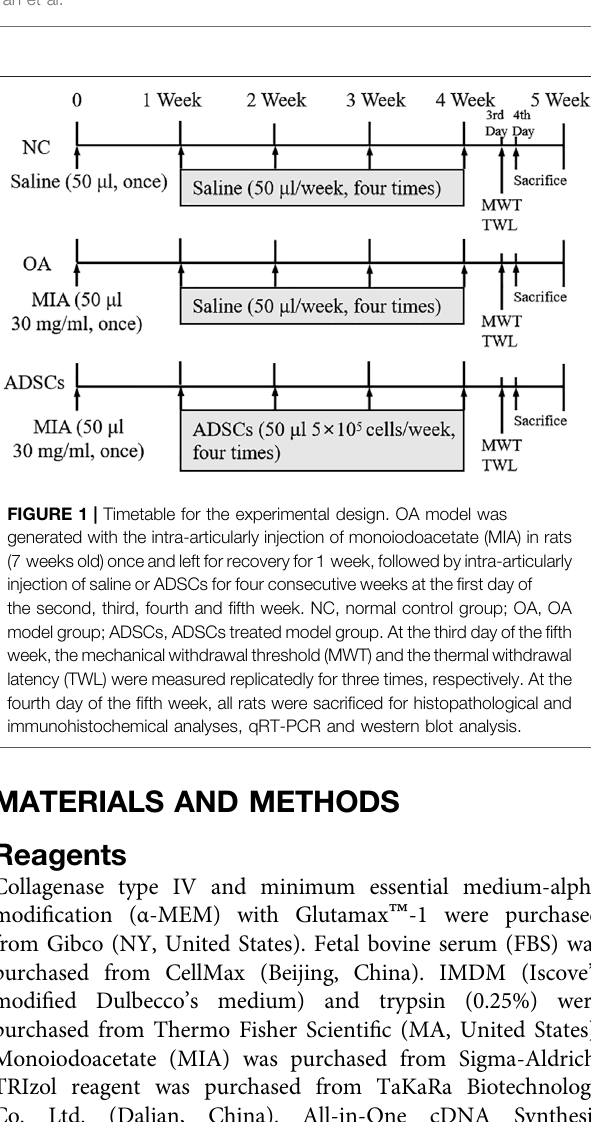
Frontiers in Pharmacology |